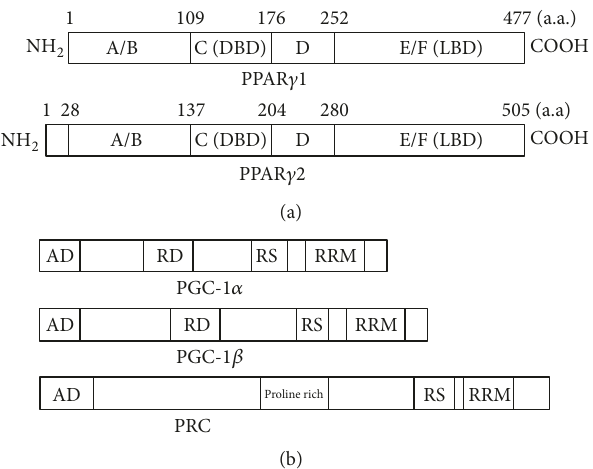
Figure 1: Structure of PPAR 𝛾 (a) and the PGC-1 family (b). (a) A/B, transcriptional activation domain; C, DNA binding domain (DBD); D, hinge region; E/F, ligand binding domain (LBD). (b) AD, transcriptional activation domain; RD, transcriptional repression domain; RS, arginine/serine rich domain; RRM, RNA binding